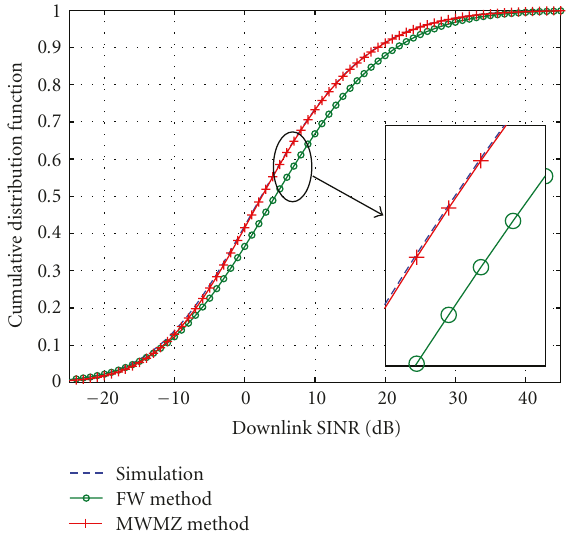
Figure 4: A comparison of the CDF obtained by the analysis with the result of Monte Carlo simulation ( σ X